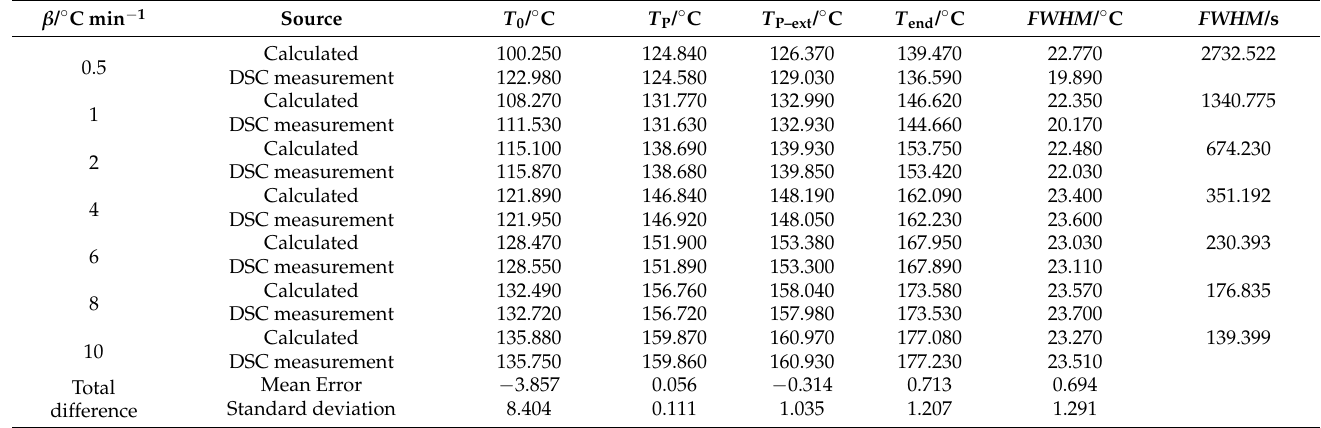
Figure 7. Peak curve plot ( a ) peak curve of the original DSC data (heat flow versus temperature); ( b ) normalized peak curve (heat flow versus temperature), ( c ) normalized peak curve (heat flow versus time). Table 1. Differences of characteristic parameter on temperatures between Mathematica calculated data and DSC measurement of BTBPC. (The numbers in red represent the values derived by this study that were significantly different from the DSC